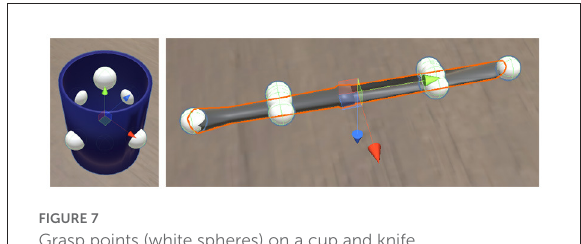
FIGURE7 Grasp points (white spheres) on a cup and knife.